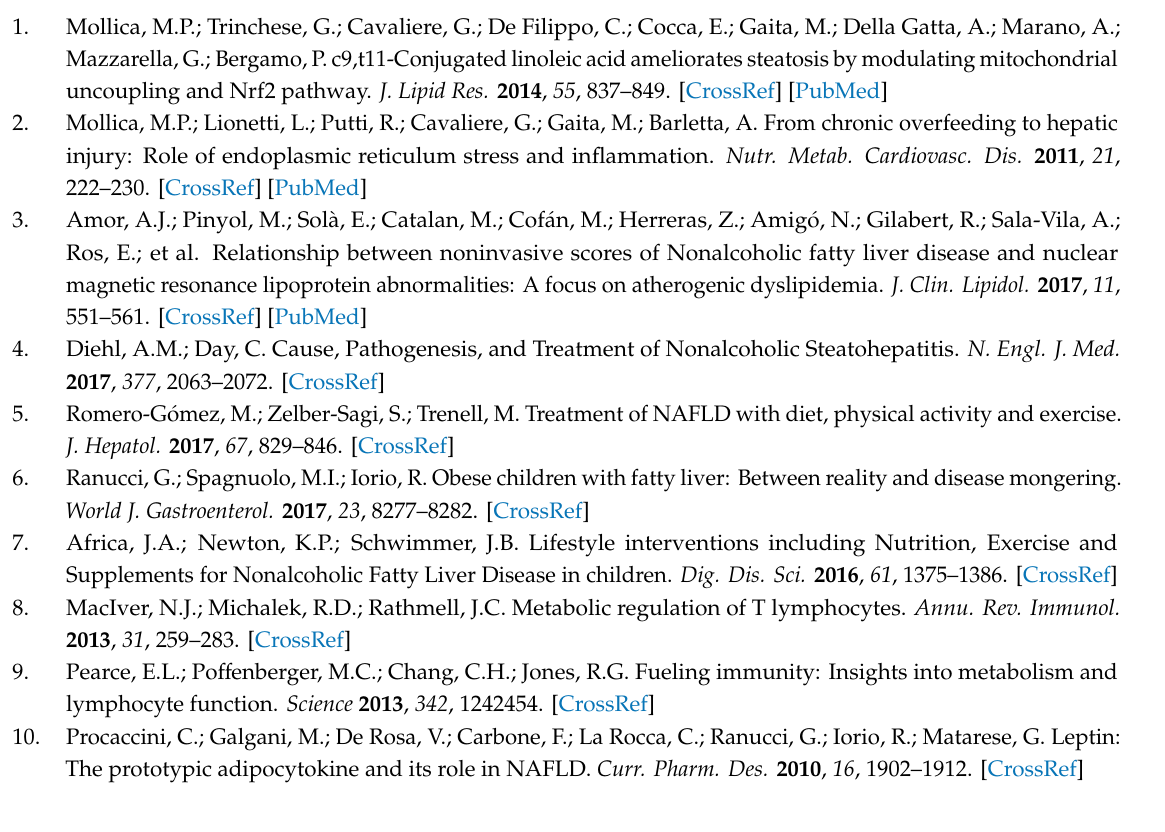
Figure S1: CONSORT Flow Diagram, Figure S2: Serum lycopene levels determined in group 2 (RCR + Tomato), Figure S3: Metabolic parameters of PBMCs isolated from children at 60 and 120 days compared to baseline (T0) upon 12 h OKT3 stimulation, Table S1: Demographic characteristics of patients, Table S2: Daily energy intake and RCR composition, Table S3: Body parameters at baseline and after 60, 120 and 180 days, Table S4: Serum parameters at baseline and after 60, 120 and 180 days, Table S5: Ultrasound parameters at baseline and after 60, 120 and 180 days, Table S6: Absolute number and percentage of di ff erent immune cell subpopulations in peripheral blood of children at baseline and after 60 and 120